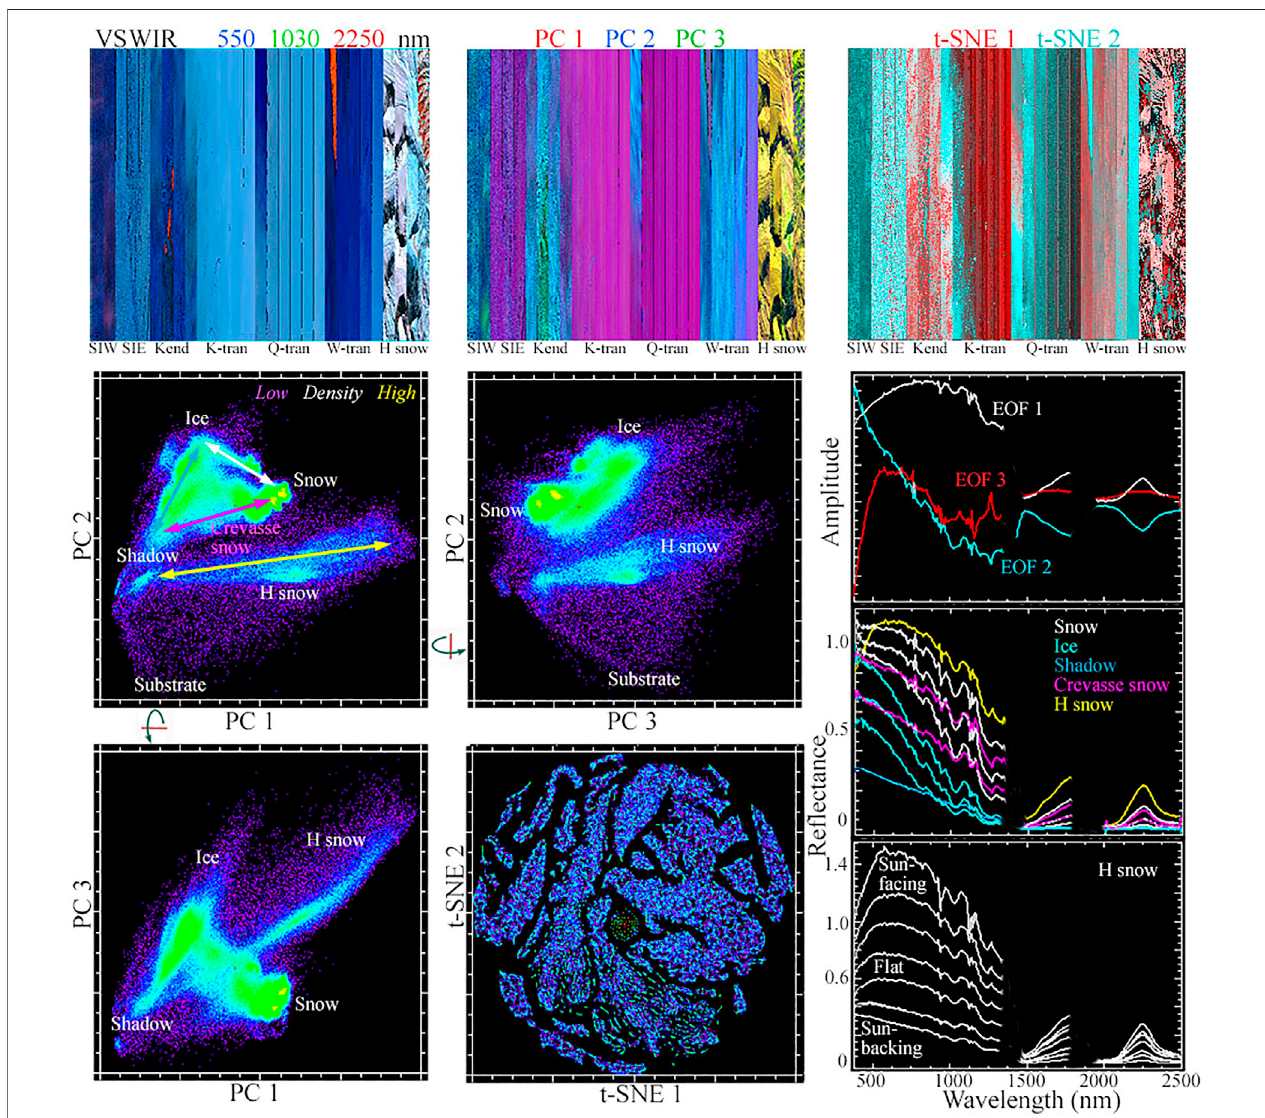
FIGURE2| CryosphericspectralfeaturespacesrenderedfromloworderPCandt-SNEprojectionsoftheAVIRIS-NGcomposite.ThePCspaceiscontinuousand bounded by compositionally distinct spectral endmembers (EMs). The fi rst three dimensions of the PC space account for 94.2, 4.4 and 0.65% of total variance, making the space effectively two dimensional. The PC space topology represents the linear combinations of the corresponding Empirical Orthogonal Functions (EOFs) that producethecontinuumofspectrainthefeaturespace.ThesimilarityofEOFs1,2tosnowandicespectragivesrisetothecontinuaofspectralshapeandamplitude along binary gradients bounding the triangular upper part of the feature space. This upper space spans gradients of clean snow and ice with amplitude modulated by shadow,waterandview/illuminationgeometry.TheuniformdirtysnowcoverintheHsnowlineformsaseparatecontinuumbetweenfullyshadowedslopesandspecular re fl ections (R > 1). Small areas of exposed rock/soil substrates form a mixing continuum between a substrate EM and the H snow mixing trend. In contrast to the continuousPC space, the clustered t-SNE space preserves fi ne scale local structure of thehigher dimensional feature spacebut givesno indication ofclusters ’ physical properties. Shapes and positions of clusters in 2D t-SNE space are effectively random but the segregation of the clusters suggests the presence of distinct fi ne scale spectral features that contribute very little ( < 1% total) variance, dispersed among the many higher order dimensions of the PC space.